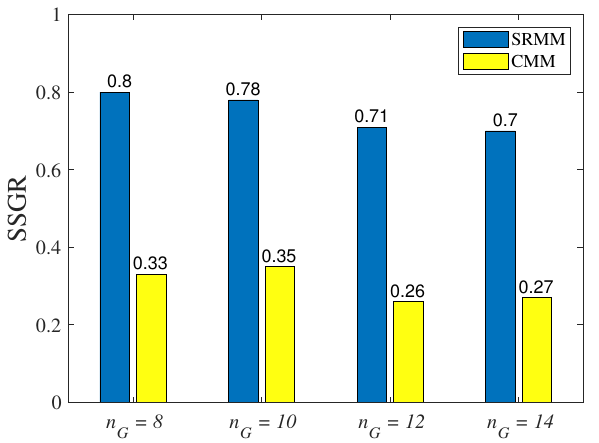
Figure 8. The same social group ratio values for SRMM and CMM from various n G values.